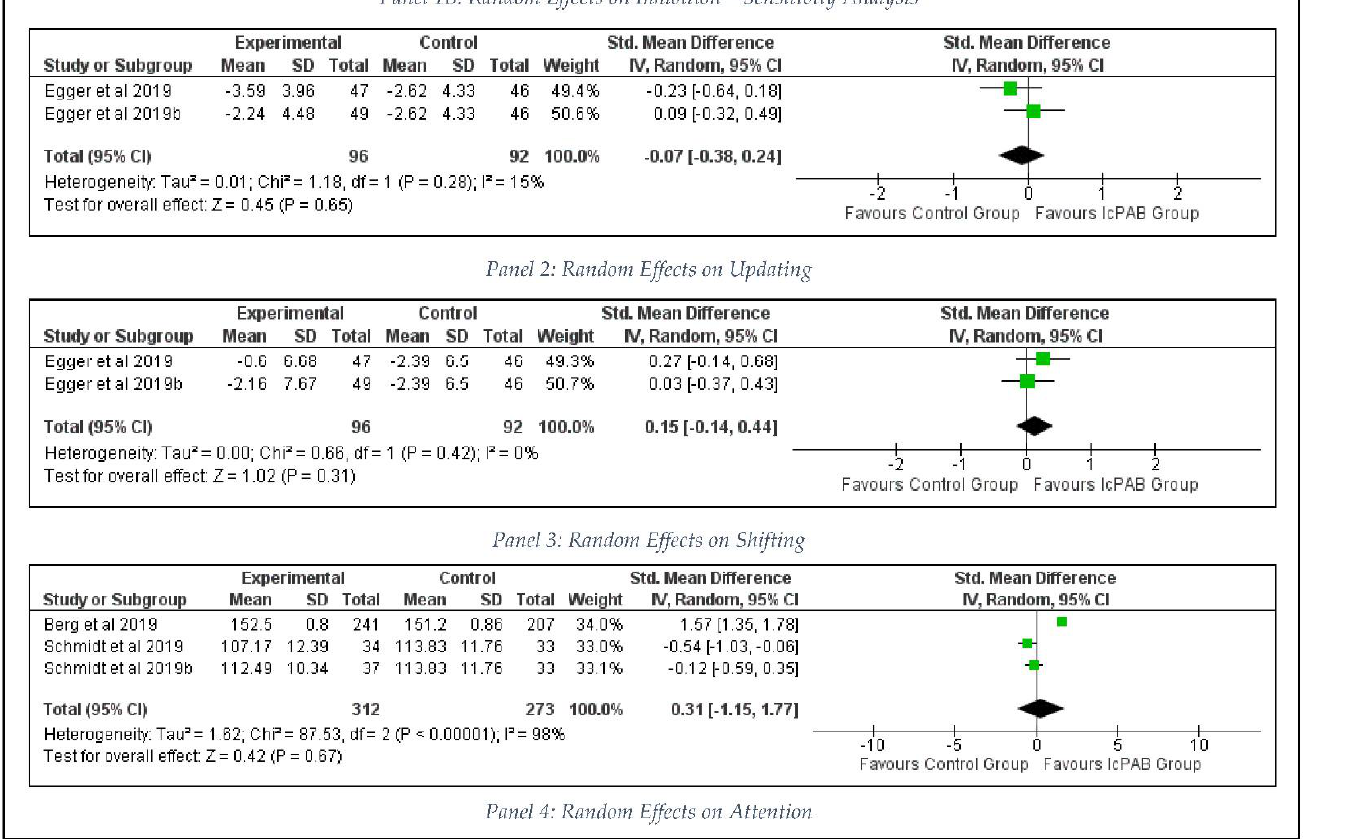
Figure 3. Effects of IcPAB on Cognitive Outcomes.